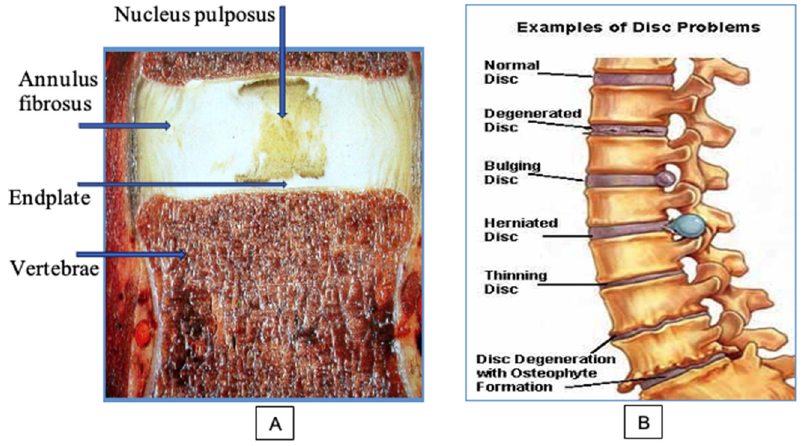
Figure 1. Structure and problems of the spinal disc: ( A ) main components of the disc; ( B ) the sequence of the development of degenerative disc diseases.